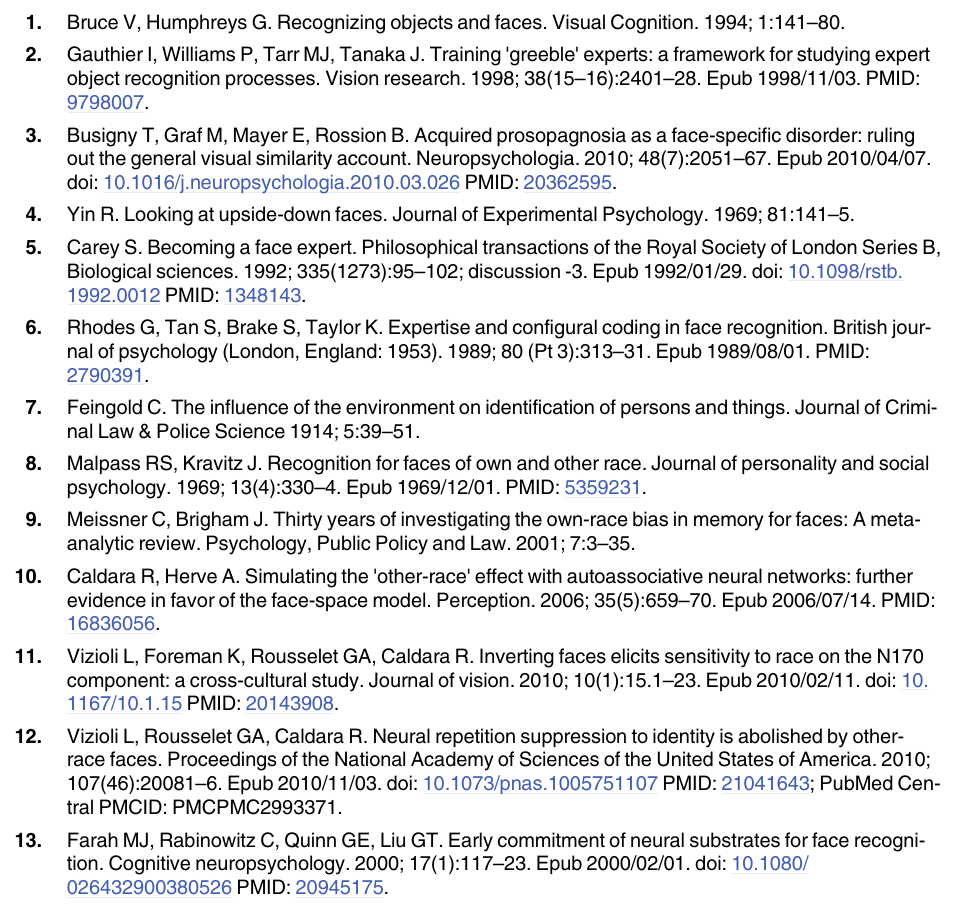
S1 Table. Results of the cluster analyses for Experiments 2 and 3. The ZR scores correspond to the Z Fisher ’ s tranformed correlations between the individual fixation maps and the proto- typical local and global models (see